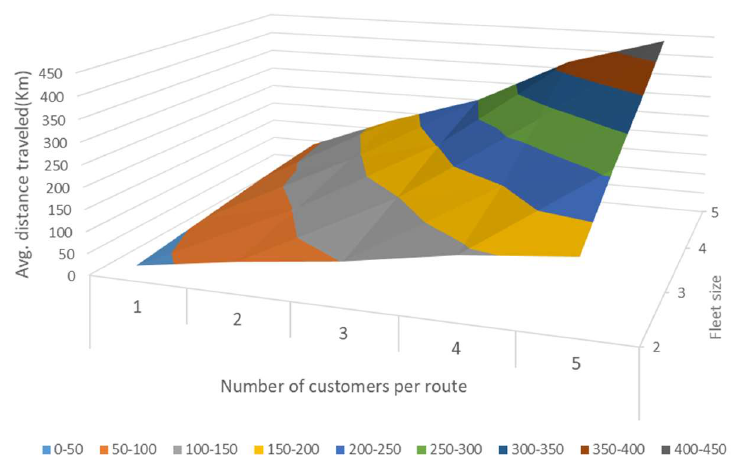
Figure 12. An illustration showing that adding nR satisfies the collision avoidance constraint.